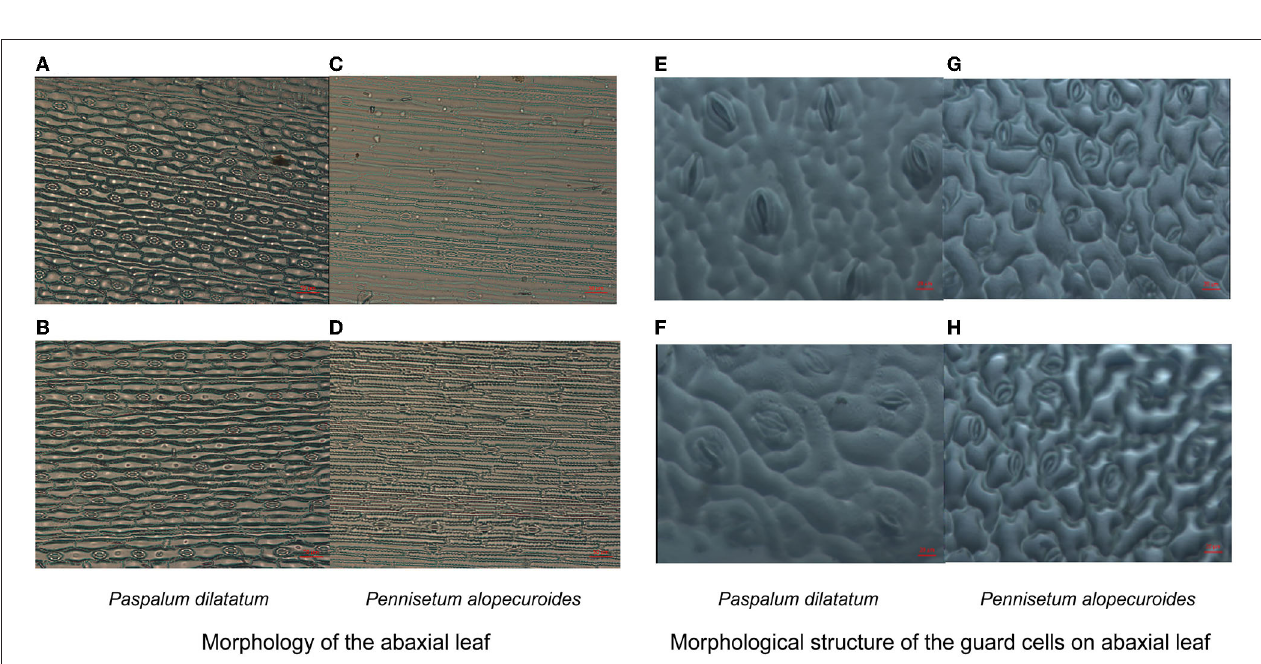
FIGURE 5 | Morphology of the abaxial leaf (A–D) and structure of the guard cells on abaxial surface (E–H) of the invasive ( Paspalum dilatatum ) and native plant ( Pennisetum alopecuroides ) in control and Cd stress treatments. Images were taken by light microscope for stomatal density with 50- µ m scale and for guard cells with 20- µ m